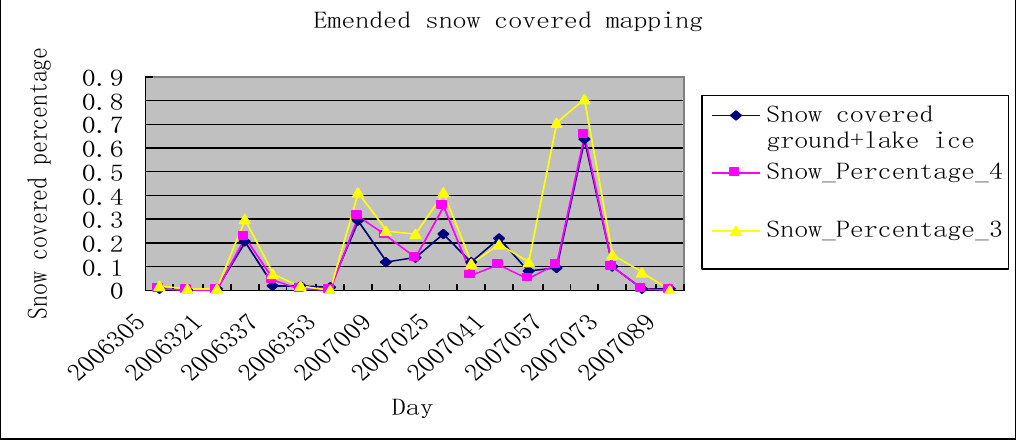
Figure 14. Emended snow covered mapping of 2006–2007 winter. Emended snow covered mapping